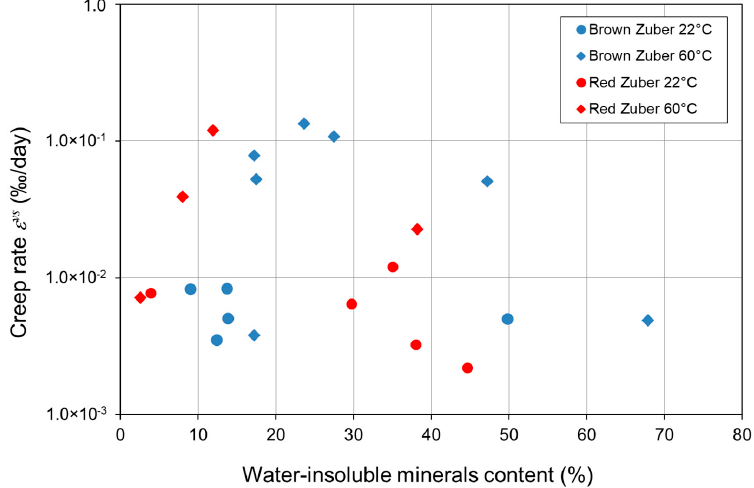
Figure 20. Steady-state creep rate of the Brown and Red Zuber unit samples, depending on the water-insoluble minerals content.